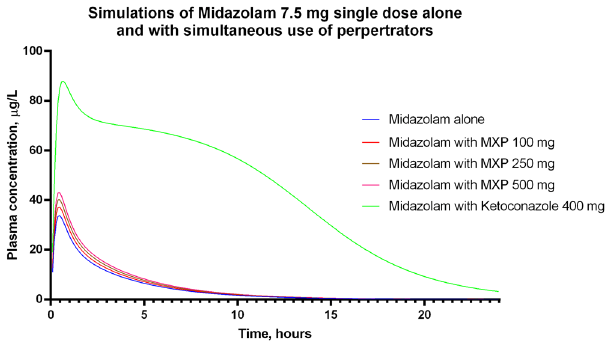
Figure 3. Simulation of midazolam alone (7.5 mg single dose) and the simultaneous administration of 100, 250 and 500 mg with a single dose of methylxanthine isolated from Pu-erh . The used positive control was ketoconazole 400